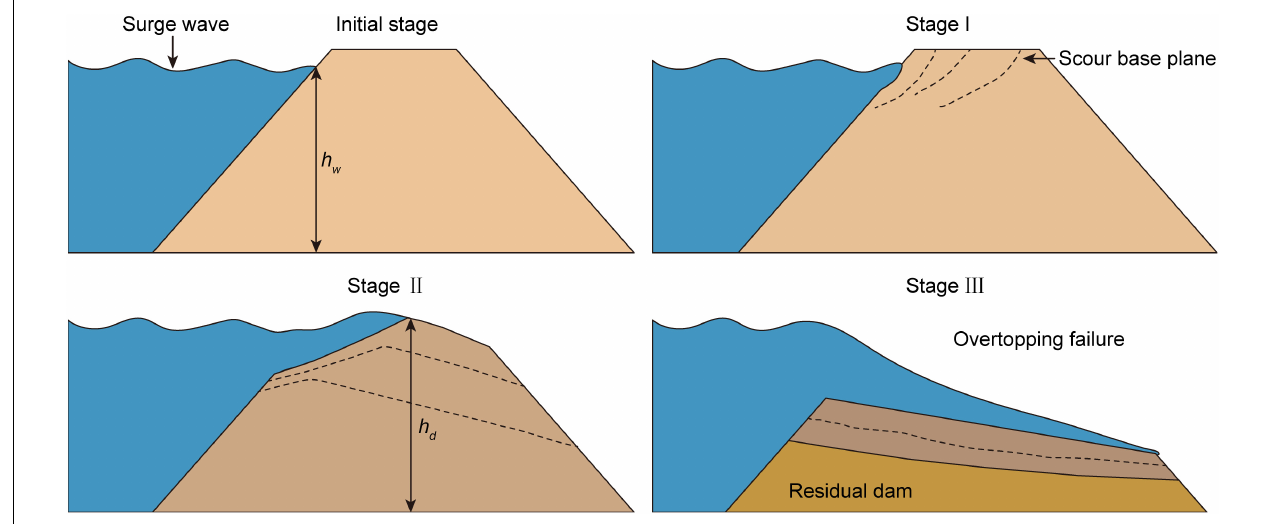
FIGURE 9 | Scouring failure process of a landslide dam by a surge wave. h w and h d are the effective water level and effective dam height,